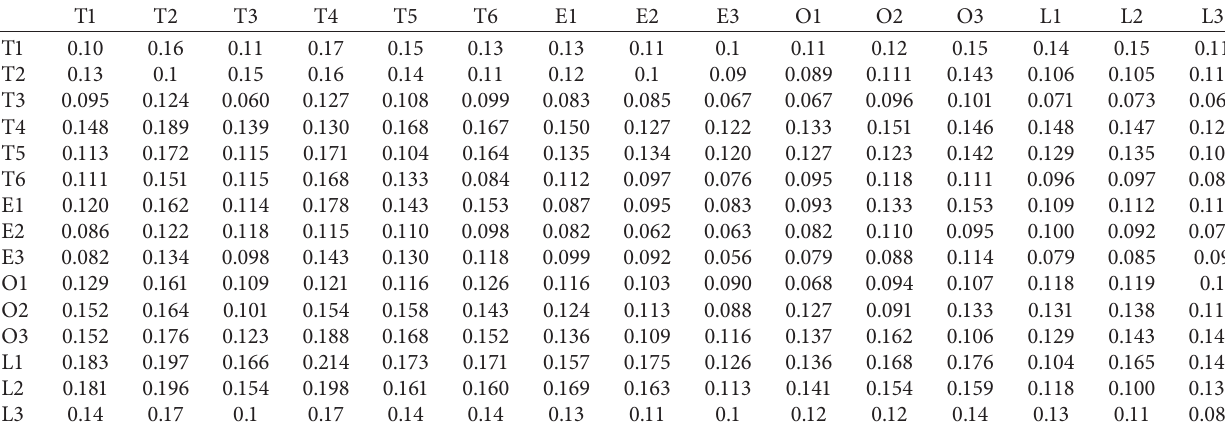
Table 11: The overall defuzzy influence matrix H .